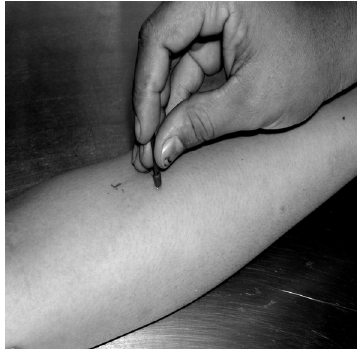
FIGURE 1 - Application of the cutaneous